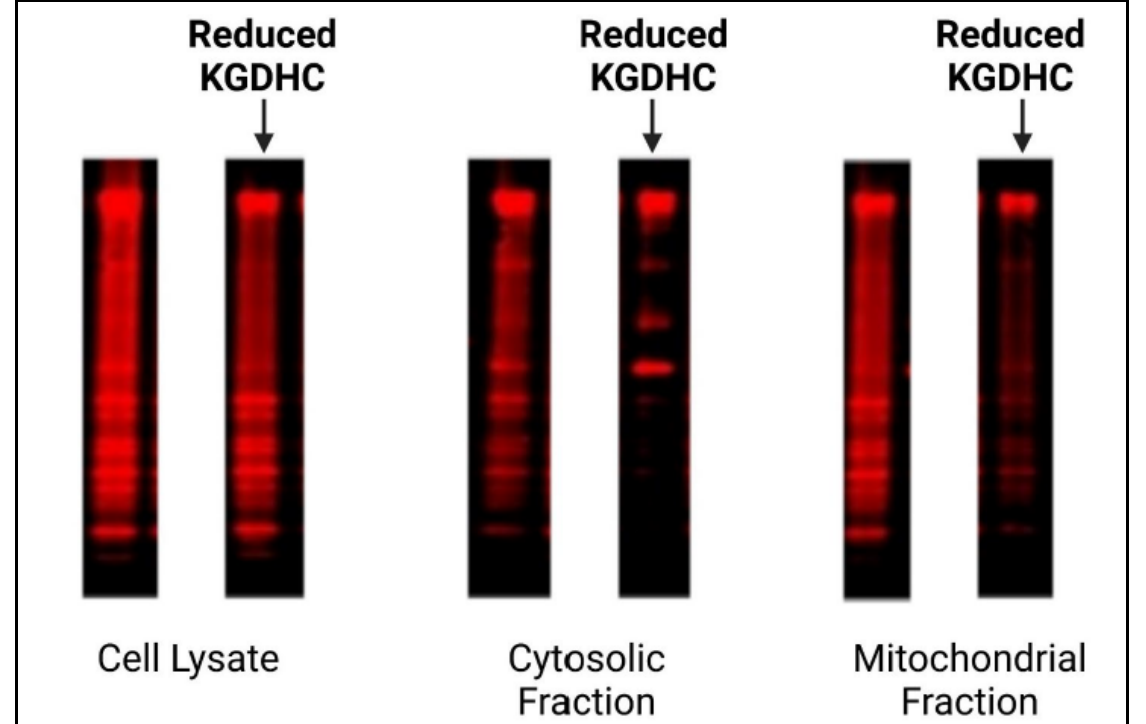
Figure 7. Inhibition of α -ketoglutarate dehydrogenase (KGDHC) reduces succinylation. Cultured neurons were incubated with or without a specific KGDHC inhibitor. The Westerns were probed with an anti-succinylation antibody. The red bands represent hundreds of succinylated proteins. In each group, the cells loaded on the lane on the right are from the KGDHC inhibited group. The blot shows the striking reduction in succinylation when KGDHC is reduced, especially in the mitochondrial fractions, demonstrating KGDHC’s role in cellular succinylation.